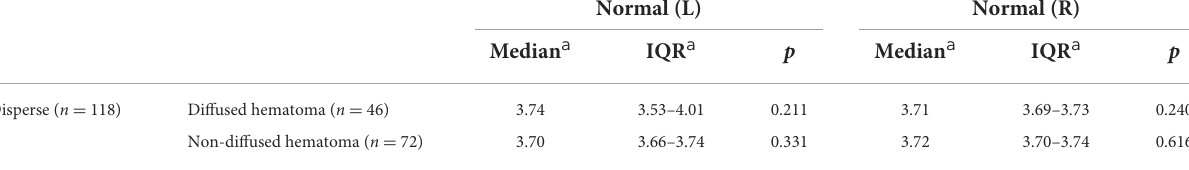
Normal (L) Normal (R)